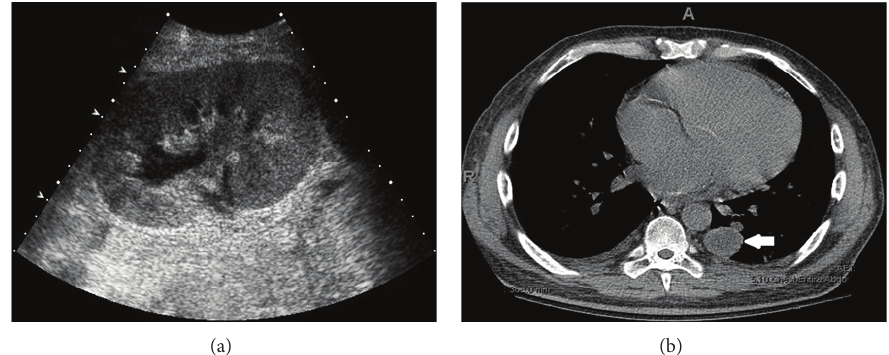
Figure 1: (a) Ultrasound showing enlargement of the transplanted kidney; (b) CT scan of the chest showing a cystic mass in the lower lobe of the left lung (white arrow).